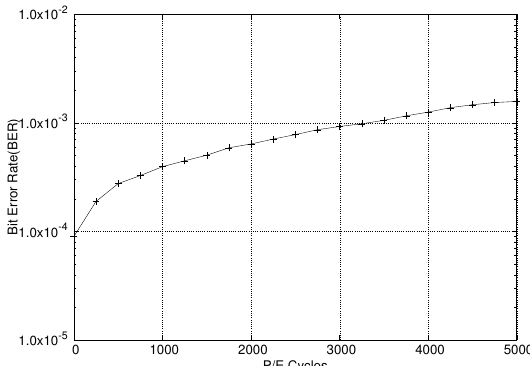
Figure 2. Evaluated bit error rates according to P/E cycles for TLC NAND flash memories